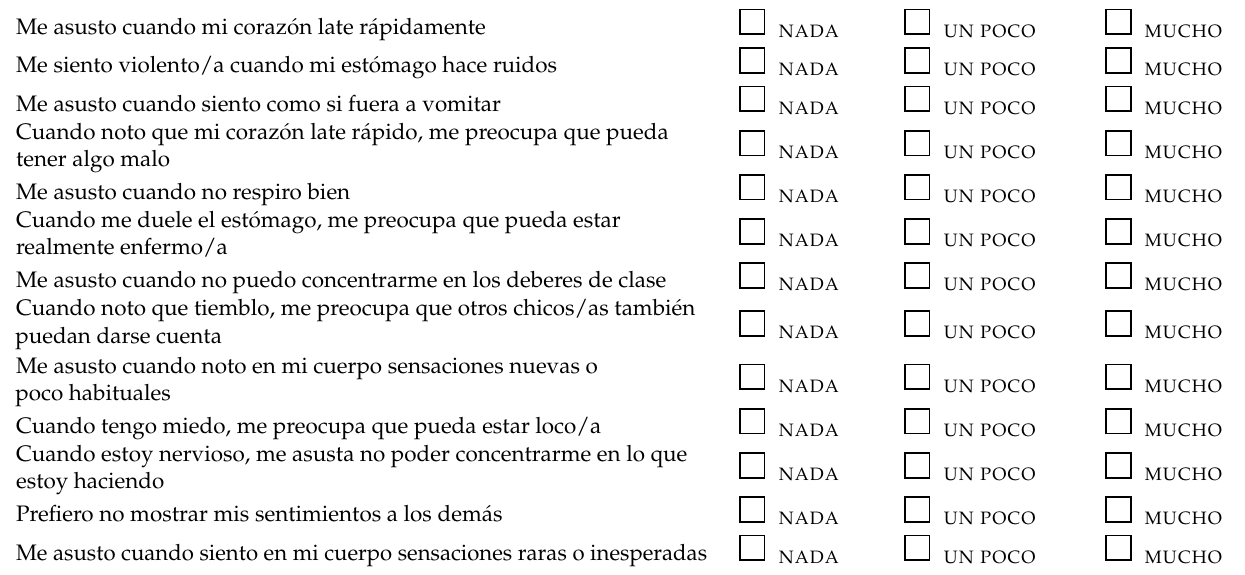
Table A2. Spanish version of the Childhood Anxiety Sensitivity Index (CASI) *.